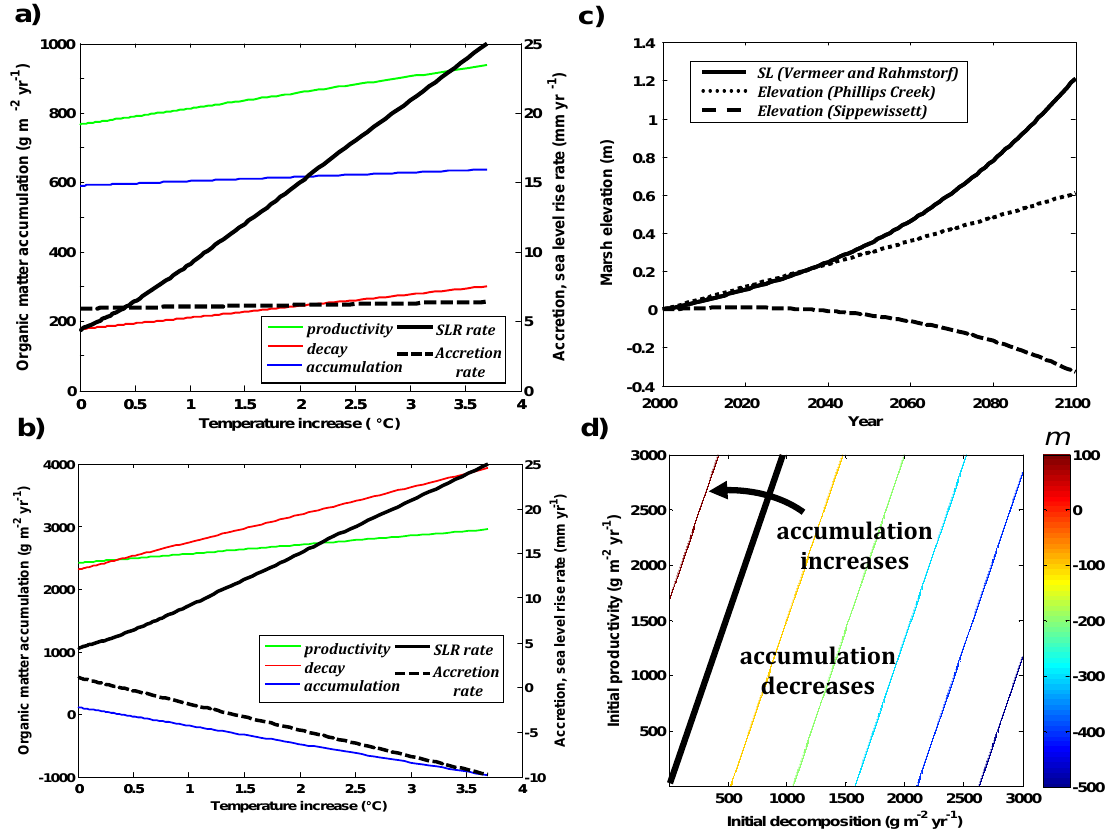
Fig. 3. Estimated changes in organic matter accumulation, accretion rate, and sea level rise rate as a function of temperature at Phillips Creek, VA (a) and Great Sippewissett, MA (b) . Integrated changes in marsh elevation and sea level through time (c) . These projections begin with modern estimates of productivity and decomposition at each site (i.e. a large surplus at Phillips Creek, and a small surplus at Great Sippewis- sett). Productivity ( p) and decomposition ( d) rates increase as a function of temperature ( T ) according to the relationships defined in the text ( p(T ) =.06 p 0 T and d(T ) =.19 d 0 T ). The organic accumulation rate equals p − d , and the organic accretion rate equals the accumulation rate divided by the dry bulk density of pure peat (0.1gcm − 3 ) . (d) The sensitivity of m to initial productivity and decomposition rates, where m describes the direction and magnitude of organic matter accumulation change with temperature ( m = .06 p 0 − .19 d 0 ) . Accumulation rates increase with temperature when m is positive, and decrease when m is